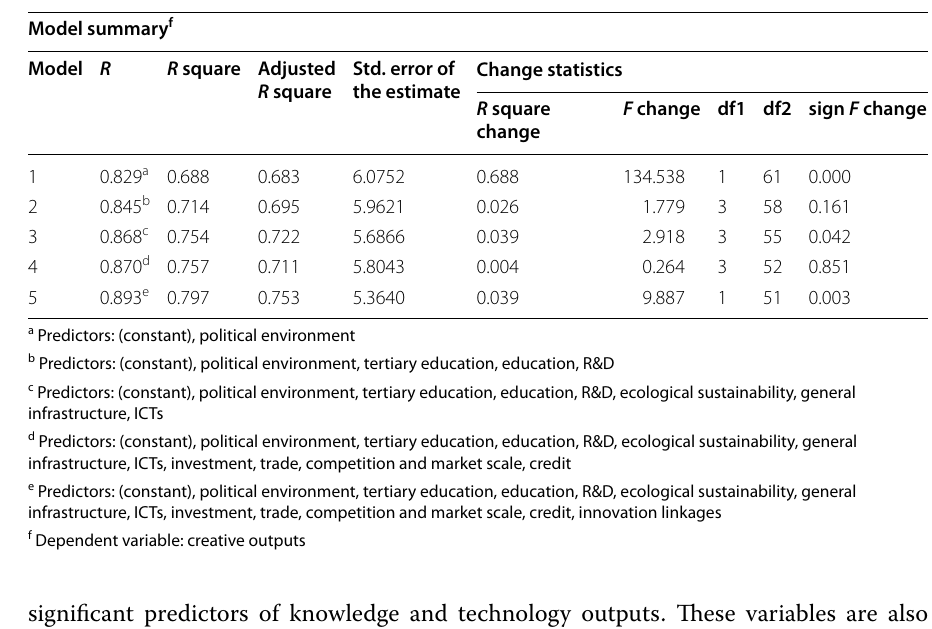
Table 7 Model summary for creative